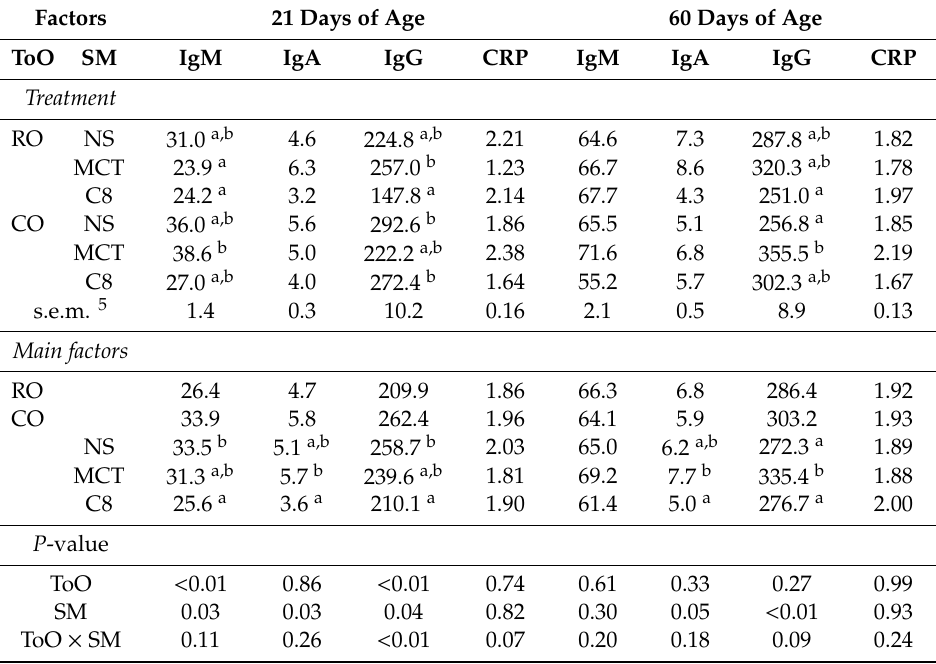
Table 11. Immunoglobin content (mg / dL) and C-reactive protein (mg / L) in piglet